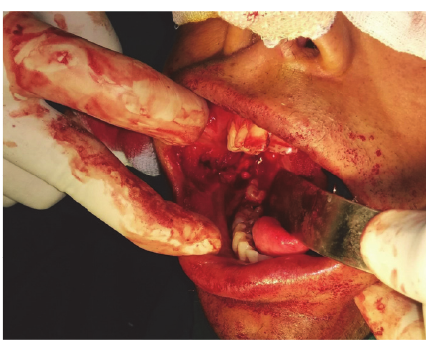
Figure 2: Surgical resection of fibrous bands.